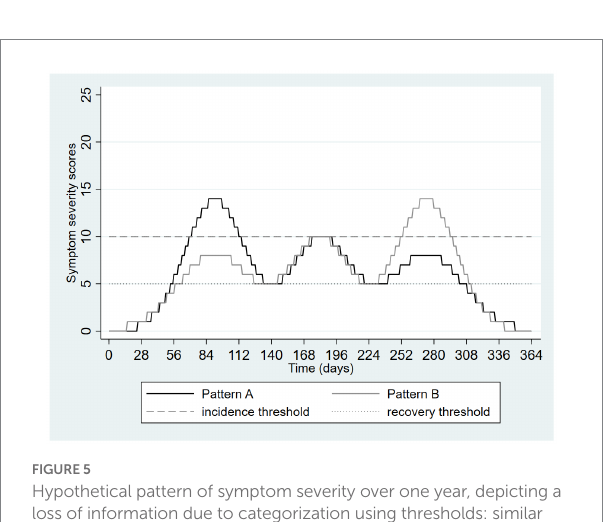
FIGURE 5 Hypothetical pattern of symptom severity over one year, depicting a loss of information due to categorization using thresholds: similar patterns are made to seem different.